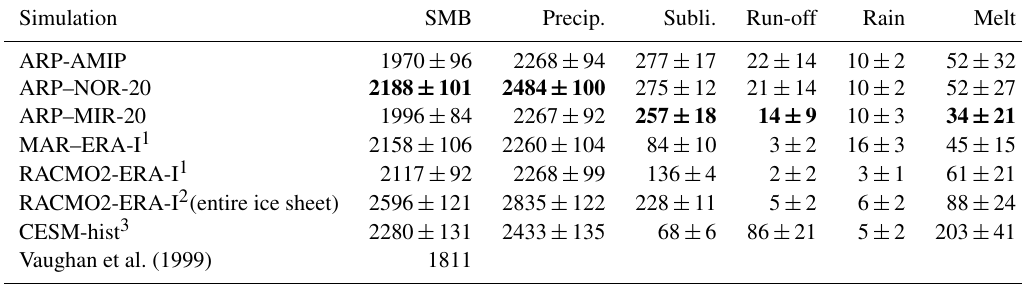
Table 4. Mean grounded AIS SMB and its component (Gtyr − 1 ) ± 1 standard deviation of the annual mean for the reference period 1981– 2010. Variables from ARP–NOR-20 and ARP–MIR-20 that are significantly different from the value in ARP-AMIP at the p = 0 . 05 level are in bold. Simulation SMB Precip. Subli. Run-off Rain Melt